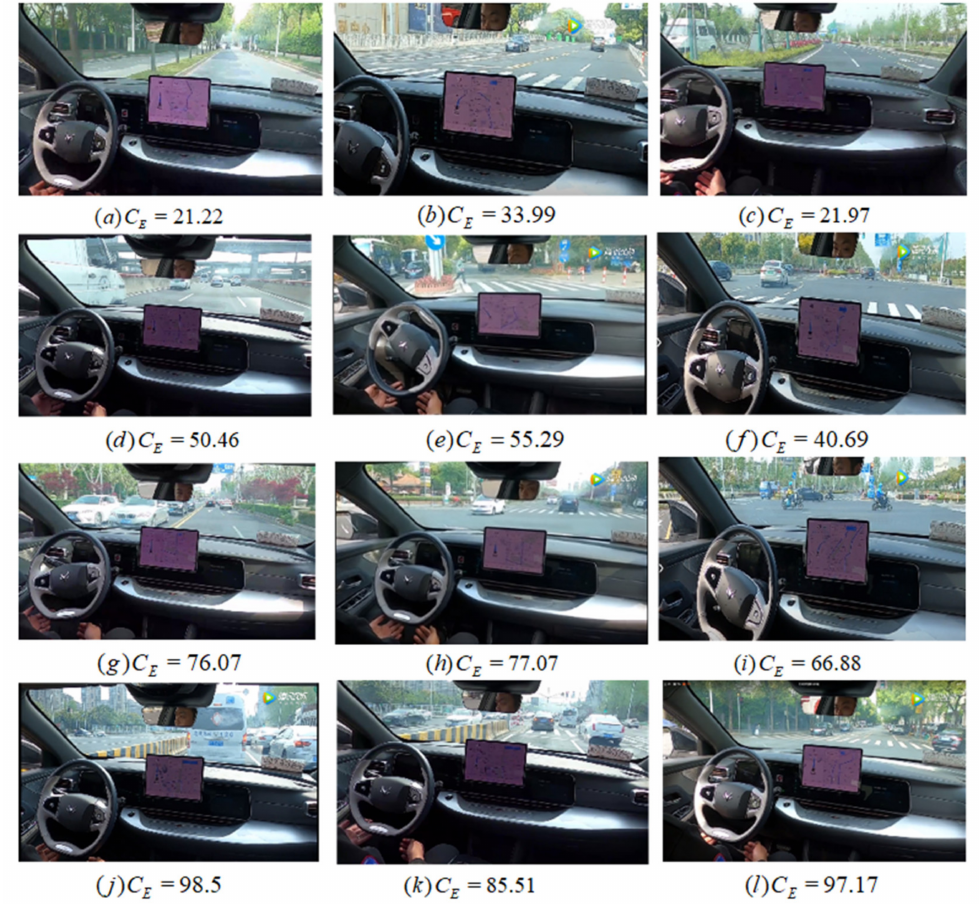
Figure 7. The experimental results of four different